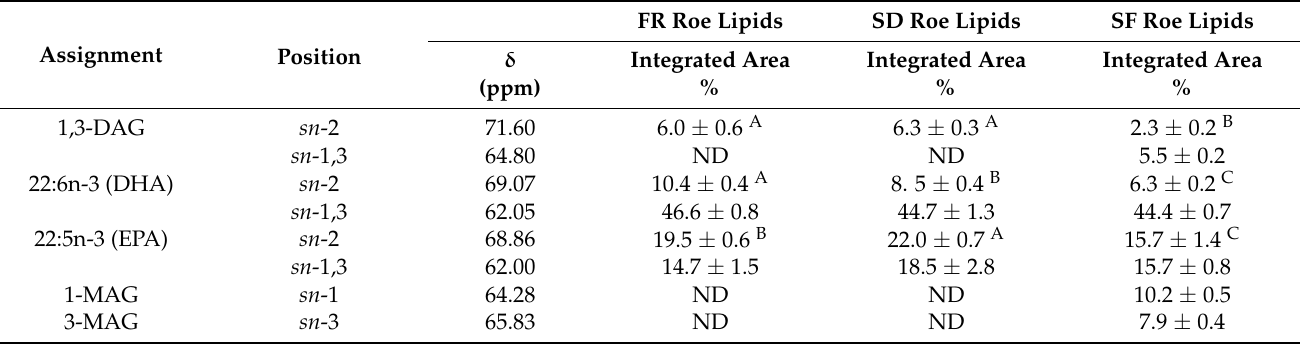
Table 3. 13 C NMR glycerol carbon region of lipids extracted from fresh (FR), salted (SD), and fermented (SF) salmon roe.